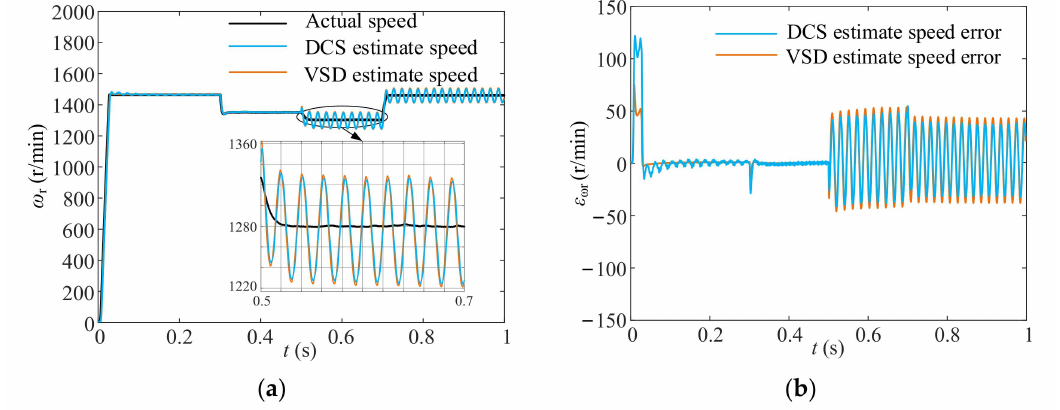
Figure 17. Electromagnetic torque. ( a ) Without stator resistance identification; ( b ) With stator resistance identification.